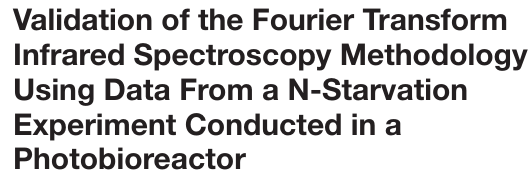
determined manually (Malassez or Neubauer hemacytometers). ( Figure 3A ) or normalization ( Figure 3B ). Correlations for the other wavenumbers are found in Supplementary Figure 8 and regression equations after baseline correction and/or normalization indicated in Table 2